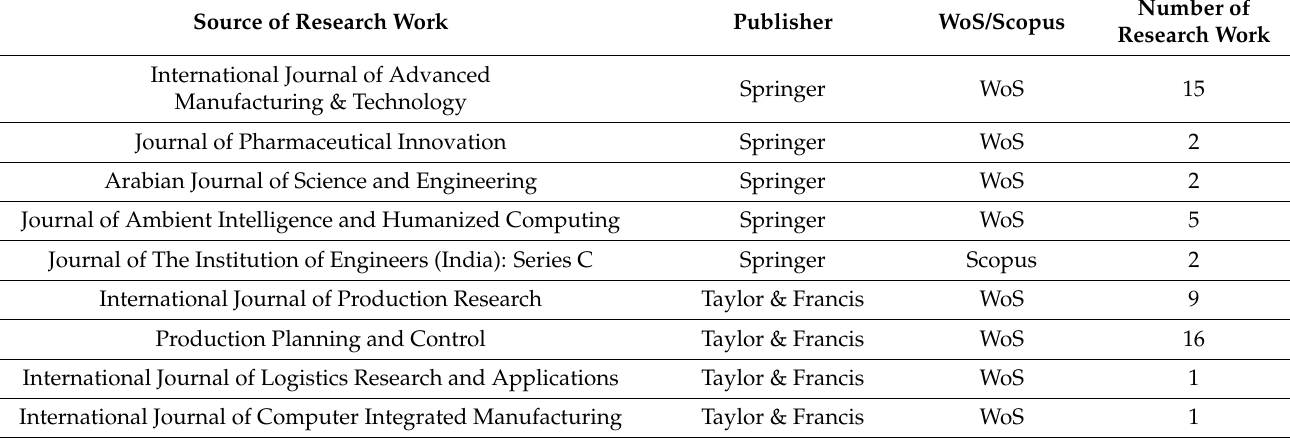
Table 1. Analysis on research works according to publisher and journals indexed in different